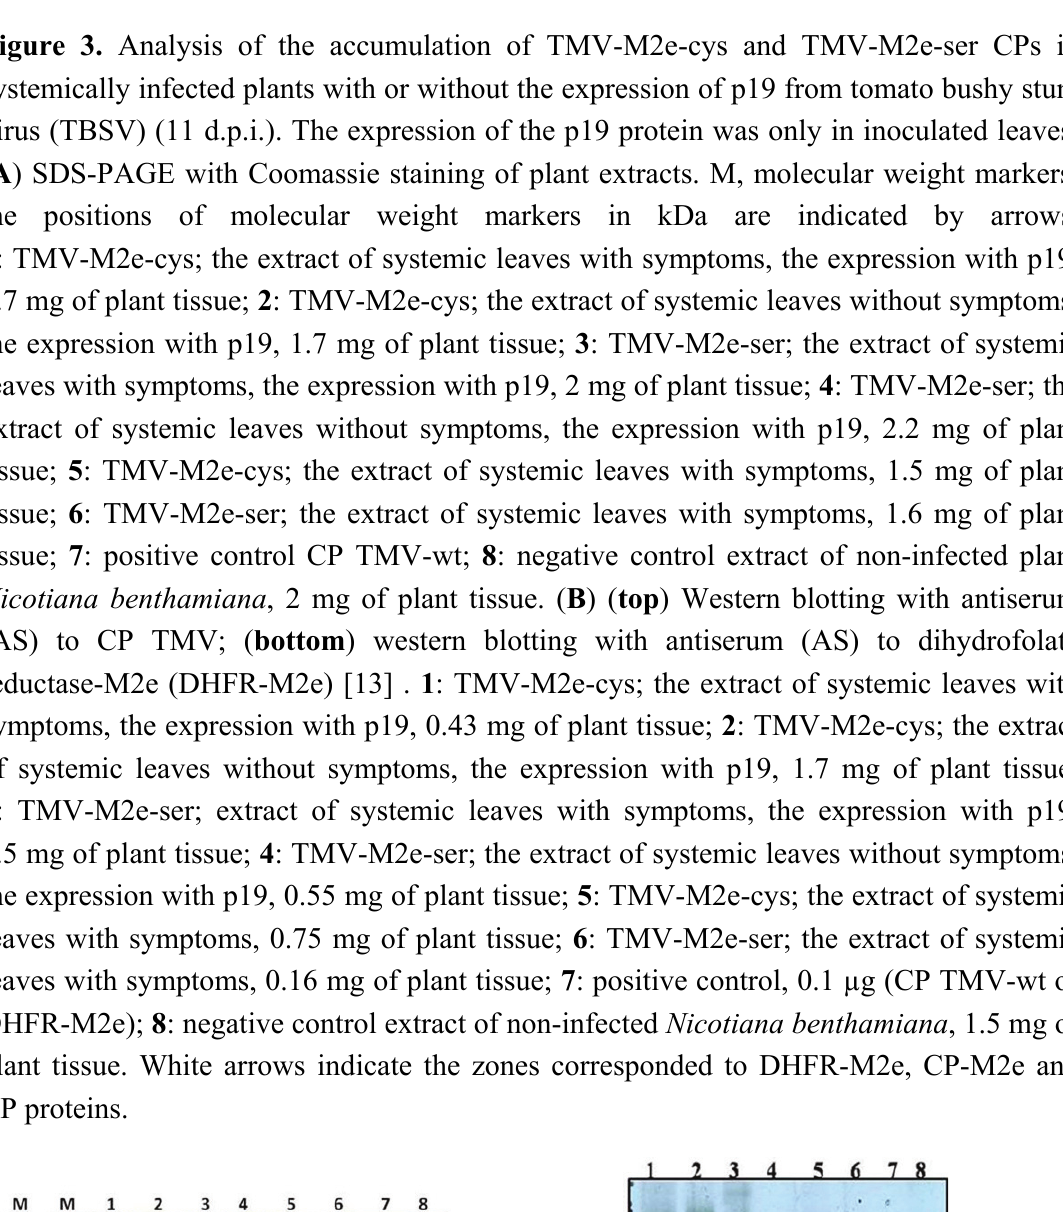
0.5 mg of plant tissue; 4 : TMV-M2e-ser; the extract of systemic leaves without symptoms,